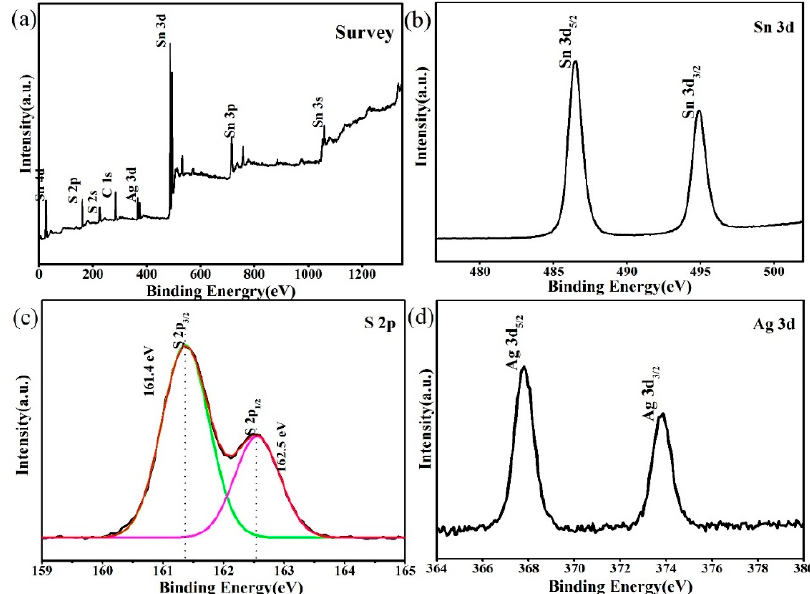
Figure 4. The X-ray photoelectron spectroscopy of 3% Ag 2 S@SnS 2 composite.